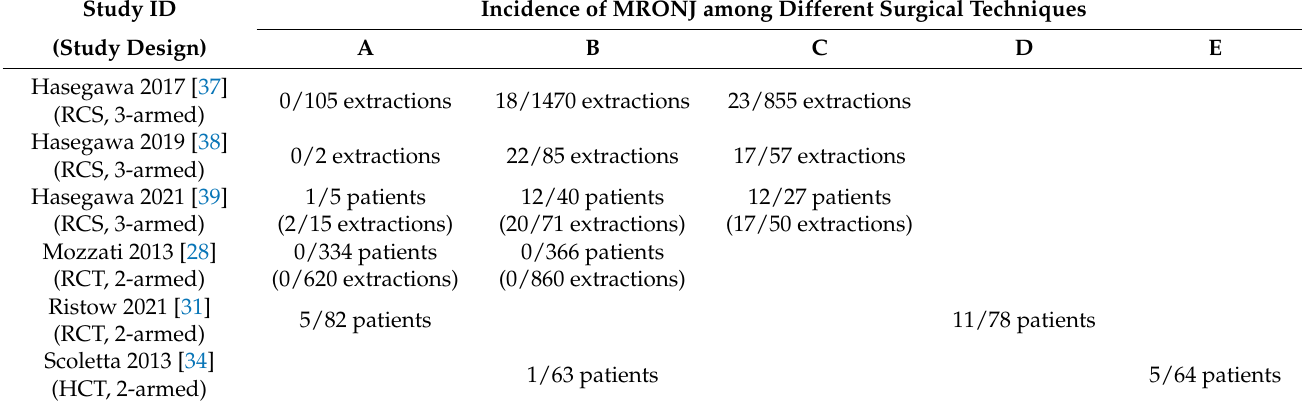
Table 5. Comparison of different surgical